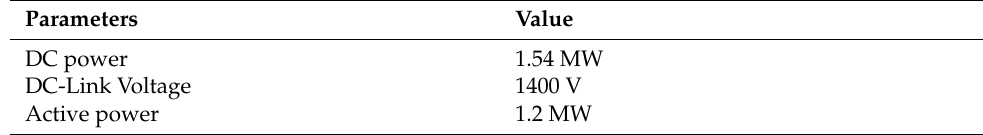
Table 4. Inverter parameters